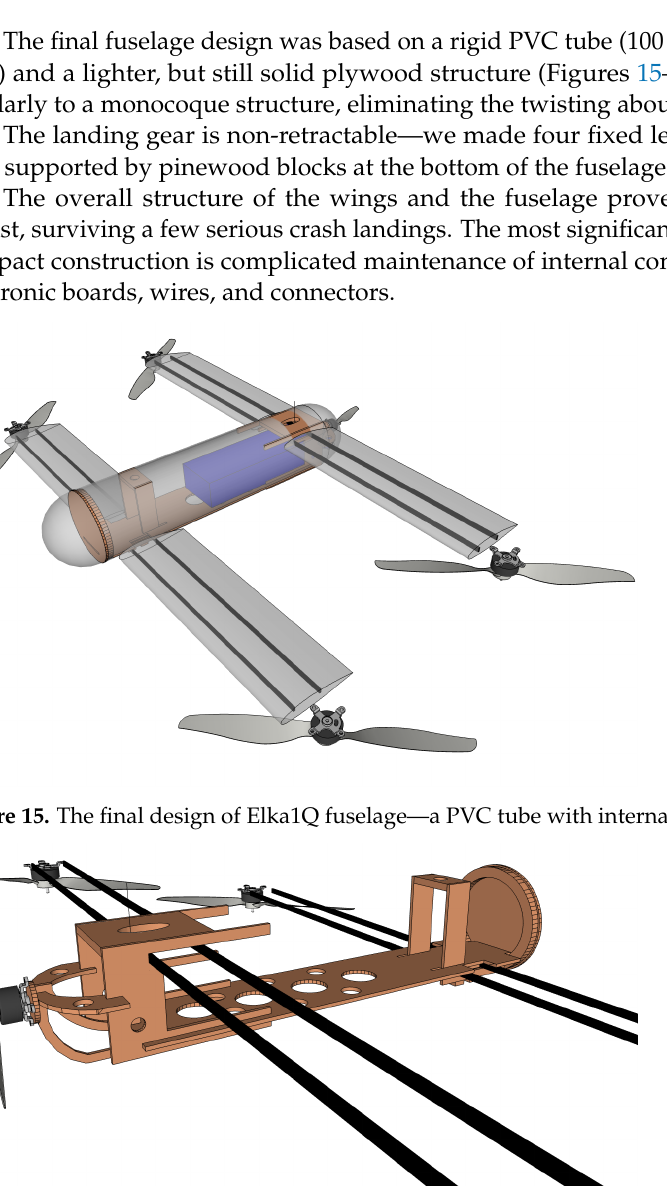
Figure 14. Flight tests revealed that the early Elka1Q fuselage was twisting about the longitudinal axis (see the arrows).